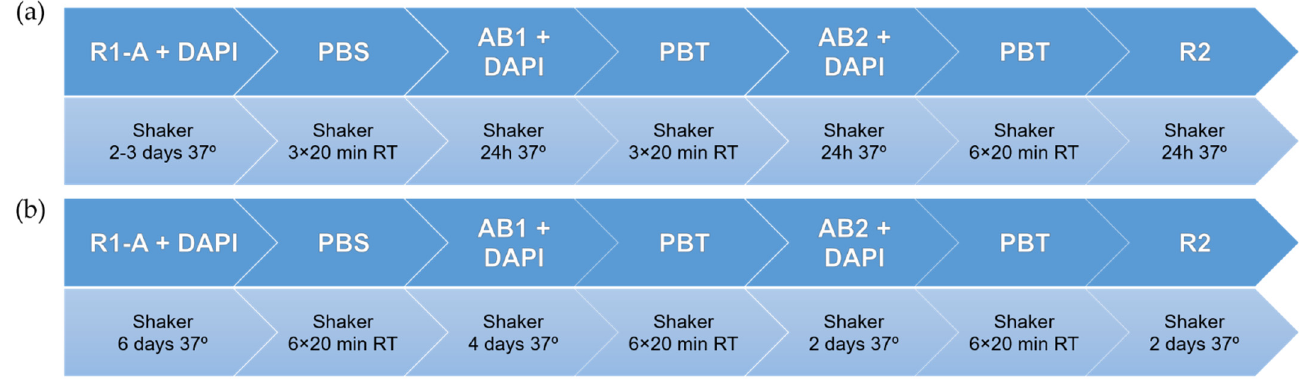
Figure 1. CUBIC 1-A clearing and immunohistochemistry (IHC) staining protocols for ( a ) human melanoma slices and ( b ) larger human melanoma pieces.